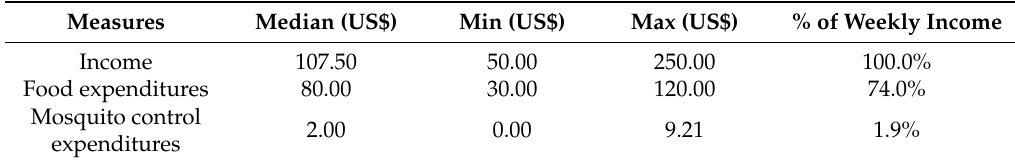
Table 4. Weekly household expenditures reported by survey respondents ( n =